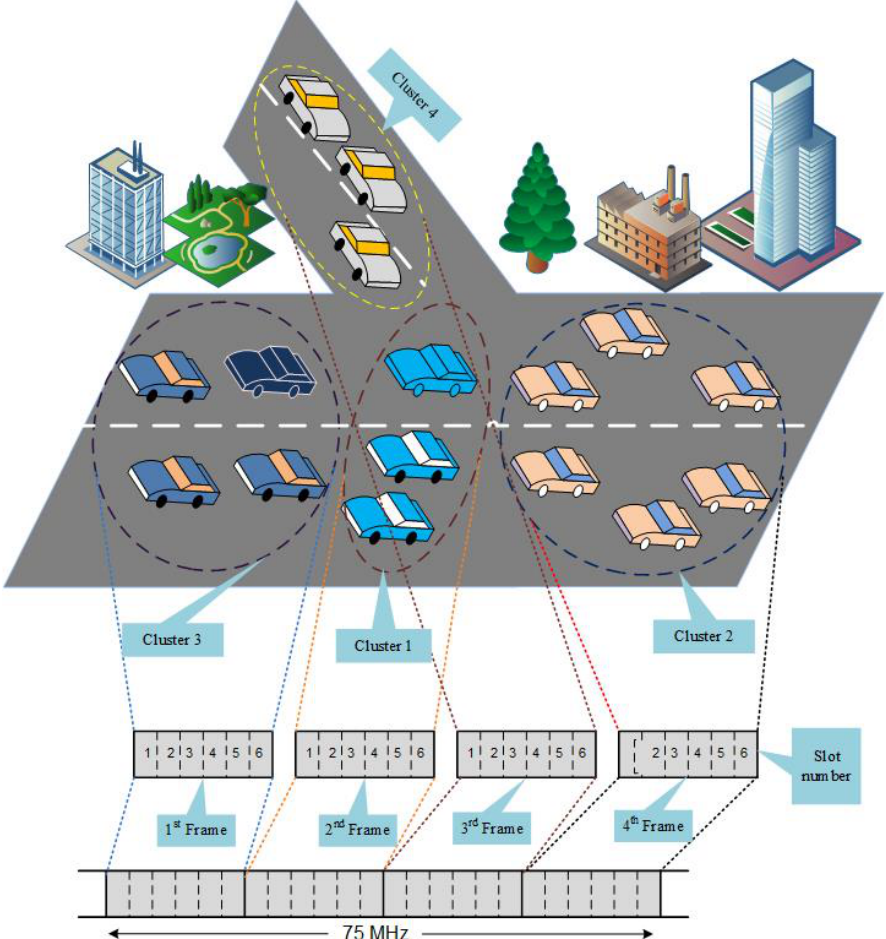
Figure 3. Allocation of the TDMA time period depending on